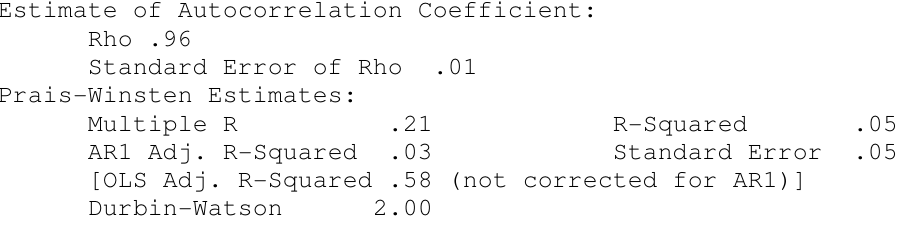
Time Series Regression of Sea Power Concentration modified by Hegemonic Level (SEAHEG), 1500-1975 ------------------------------------------------------------- Estimate of Autocorrelation Coefficient: Rho .96 Standard Error of Rho .01 Prais-Winsten Estimates: Multiple R .21 R-Squared .05 AR1 Adj. R-Squared .03 Standard Error .05 [OLS Adj. R-Squared .58 (not corrected for AR1)] Durbin-Watson